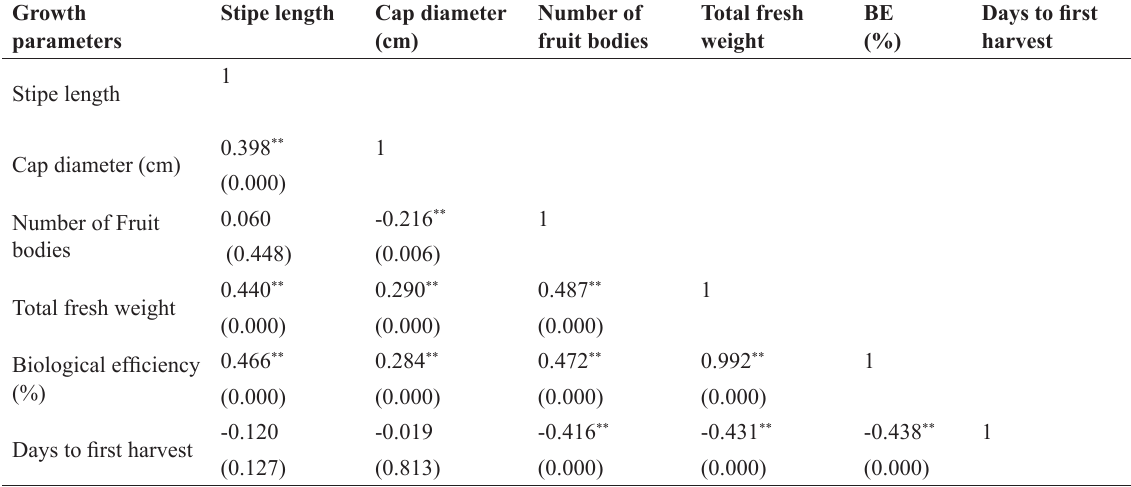
Table 5 Pairwise correlations between different mushroom growth parameters